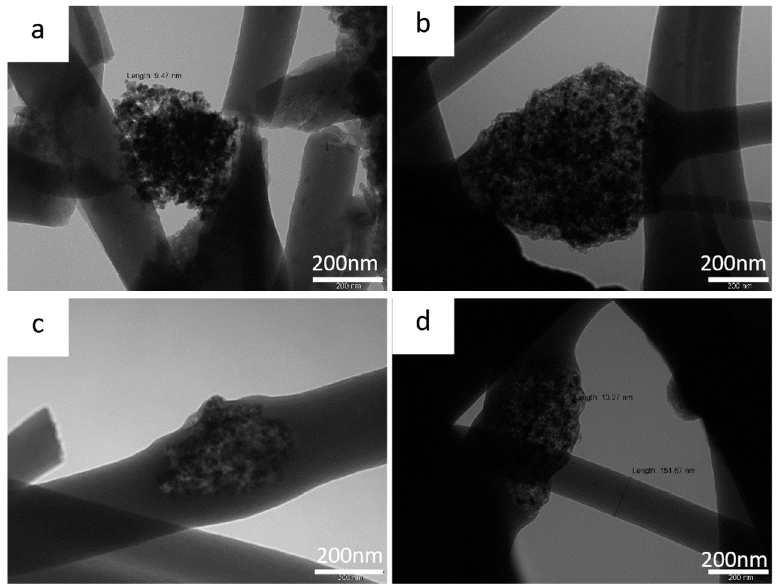
Figure 5. TEM images of ( a ) and ( b ) 10%ZnS–GO/CNF sample at 100 kX and ( c ) and ( d ) 30%ZnS– GO/CNF sample at 100 kX.